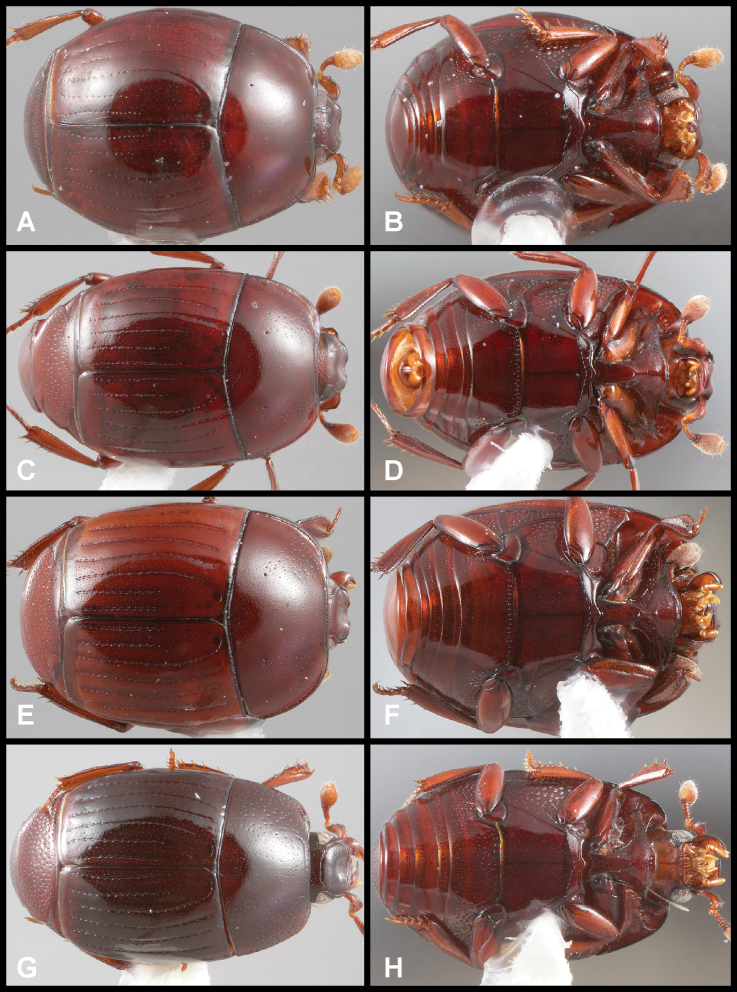
A, BPhelister
globosus: A dorsal habitus B ventral habitus C, DP.
serratus: C dorsal habitus D ventral habitus E, FP.
geminus: E dorsal habitus F ventral habitus G, HP.
parana: G dorsal habitus H ventral habitus.